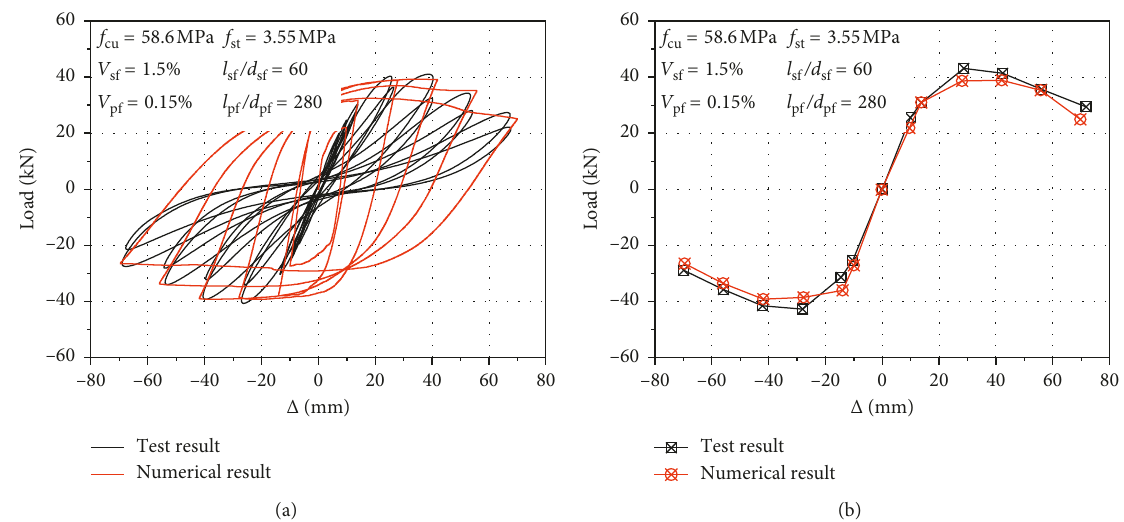
Figure 29: Comparisons of the behavior of HFRC beam-column joints between model prediction and test results. (a) Hysteretic curve. (b) Skeleton curve.